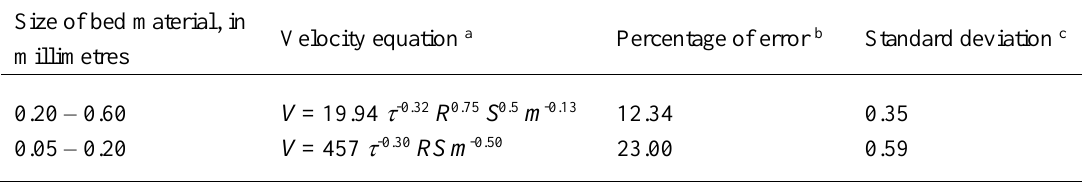
Showing Improved Equations Size of bed material, in millimetres